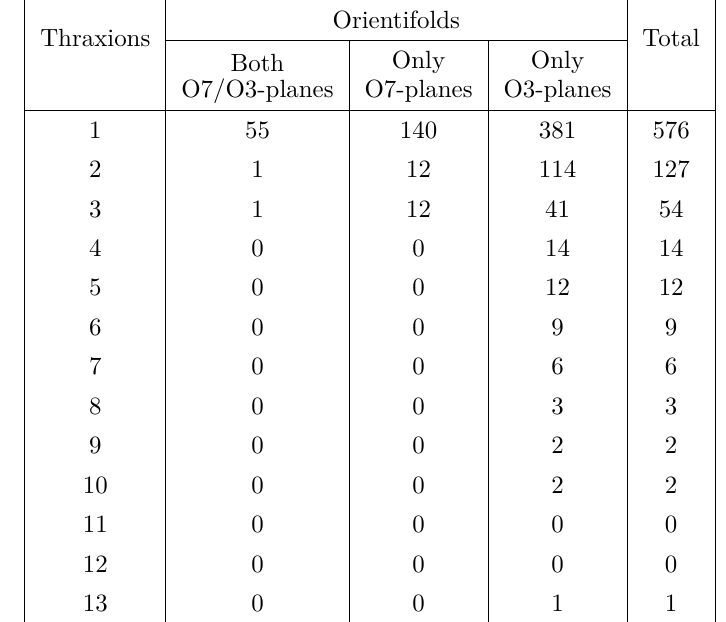
Table 3 . Number of CICY orientifolds in M 2 divided by the number of thraxions and kind of orientifolds they